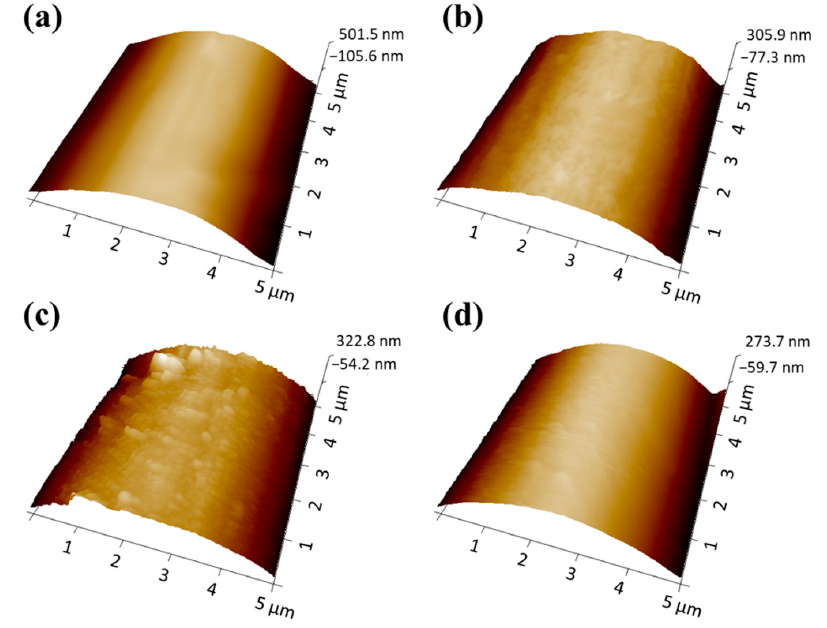
Figure 4. AFM images of PPTA fiber before plasma treatment ( a ), with plasma treatment for 1 min ( b ), 5 min ( c ) and 10 min ( d ).